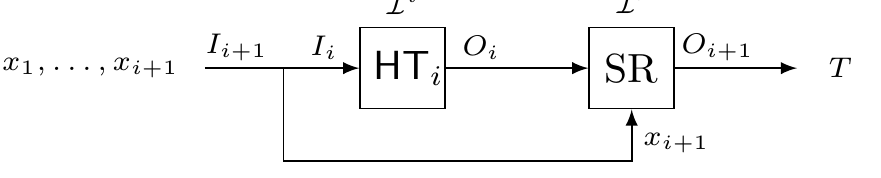
Figure 2: Illustration of the recursive HT i +1 algorithm, with observations I i +1 = I i ∪ I 0